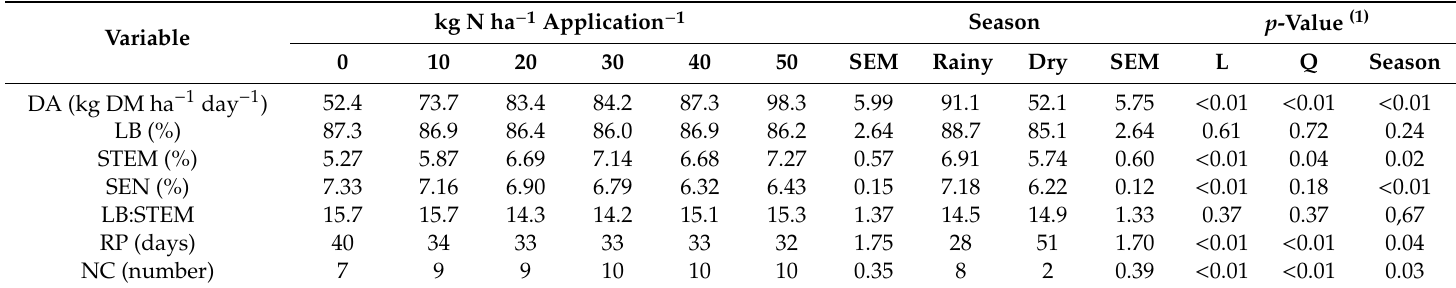
Table 3. Productive and botanical characteristics of Guinea grass.